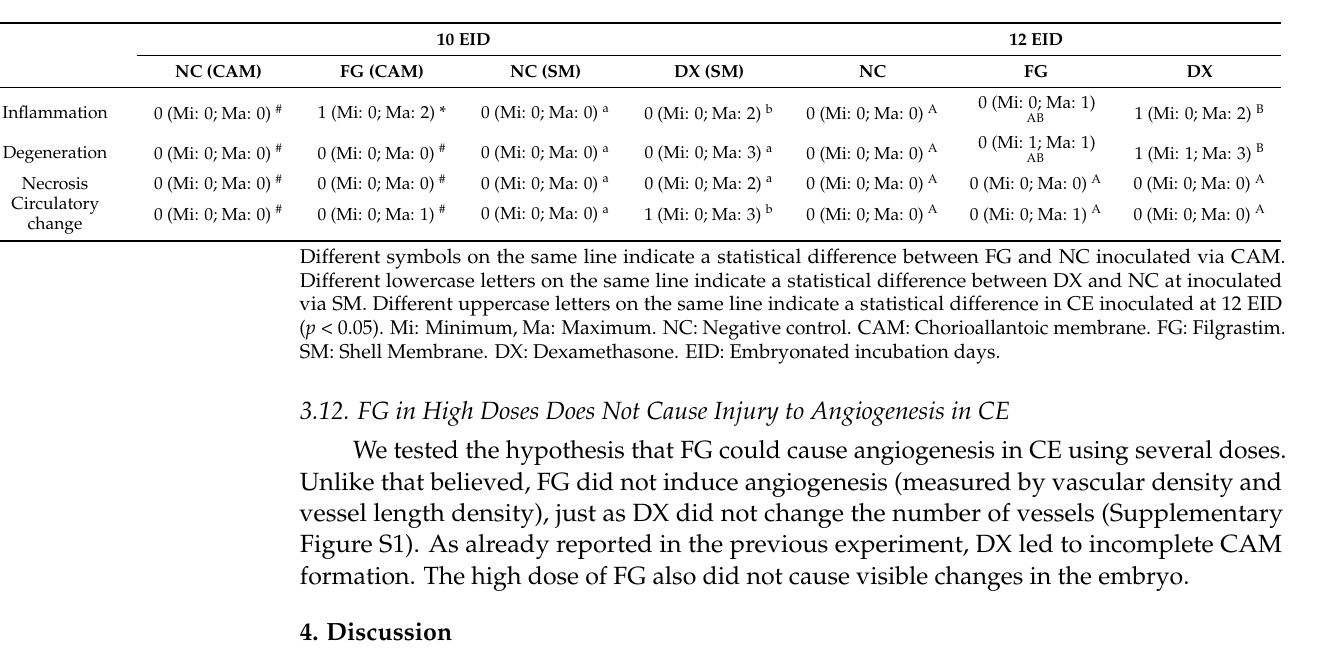
Table 10. Histopathological analysis of liver from embryos inoculated with FG and DX at 10 and 12 EID. 10 EID 12 EID